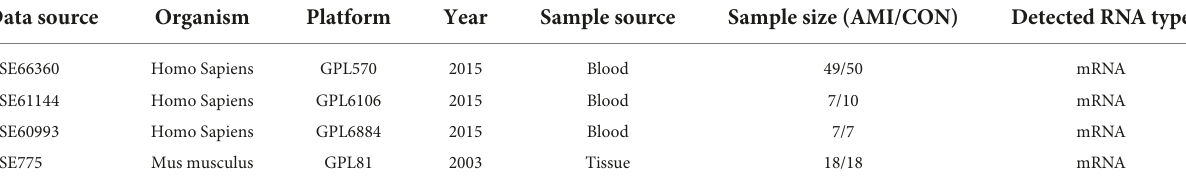
TABLE 1 The information of the 4 microarray datasets obtained from the GEO